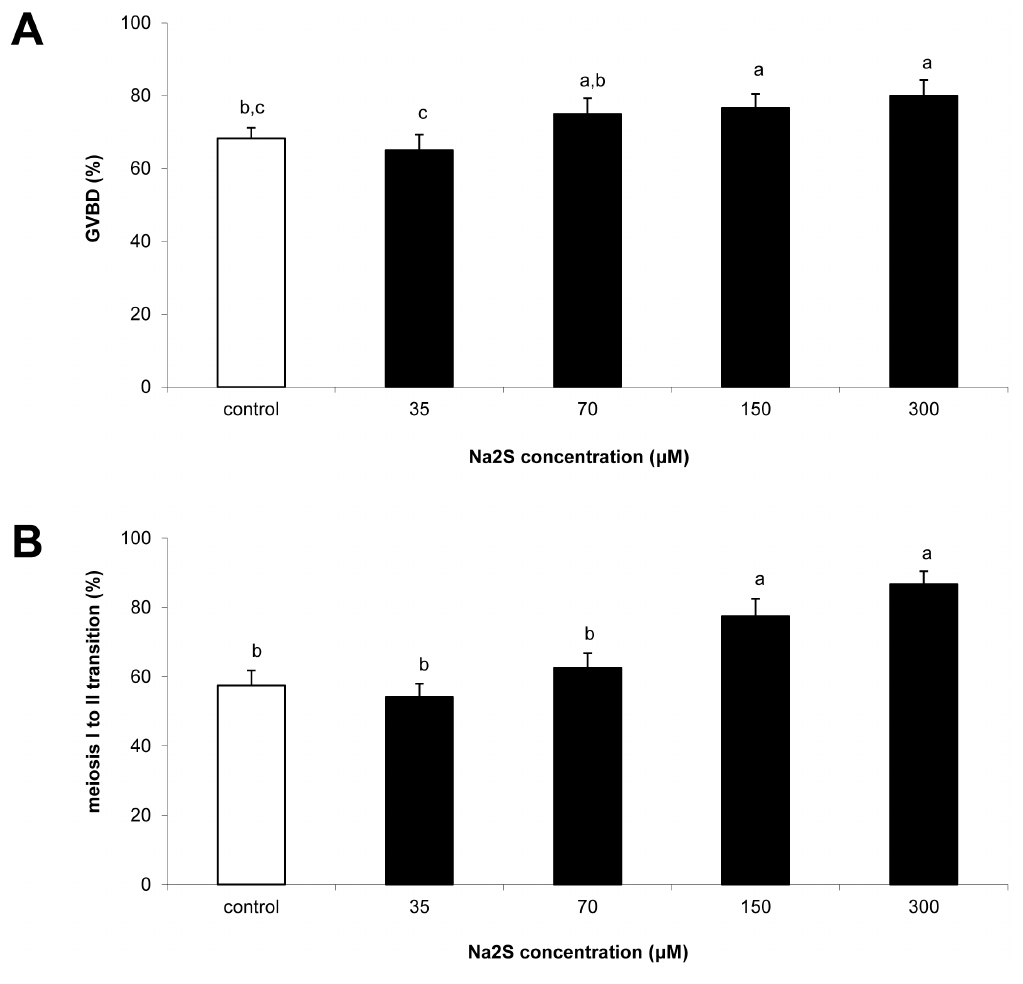
Figure 1. Effect of different Na 2 S concentrations on meiosis resumption and transition to meiosis II in oocytes. Proportion of GVBD (A) and meiosis I to II transition (B) during in vitro cultivation after 20 and 30 h in vitro cultivation, respectively. a,b,c Statistically significant differences among experimental groups (P , 0.05).